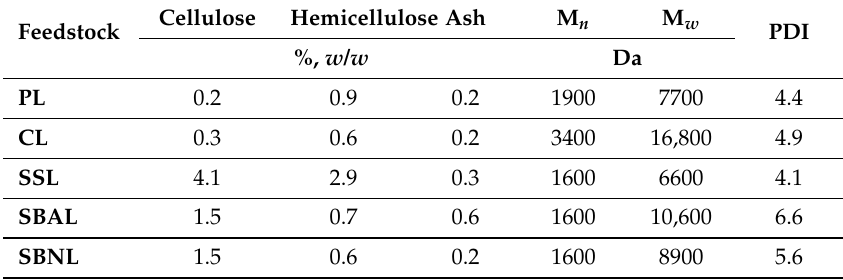
Table 2. Composition in impurities (%, w / w ) and GPC analysis of the lignin samples. The abbreviations of lignin fractionated from pine sawdust (PL), cotton stalks (CL), sweet sorghum bagasse (SSL), spruce bark with (SBAL) and without acid addition (SBNL) were used. The standard error for all measurements was < 10% of the value.